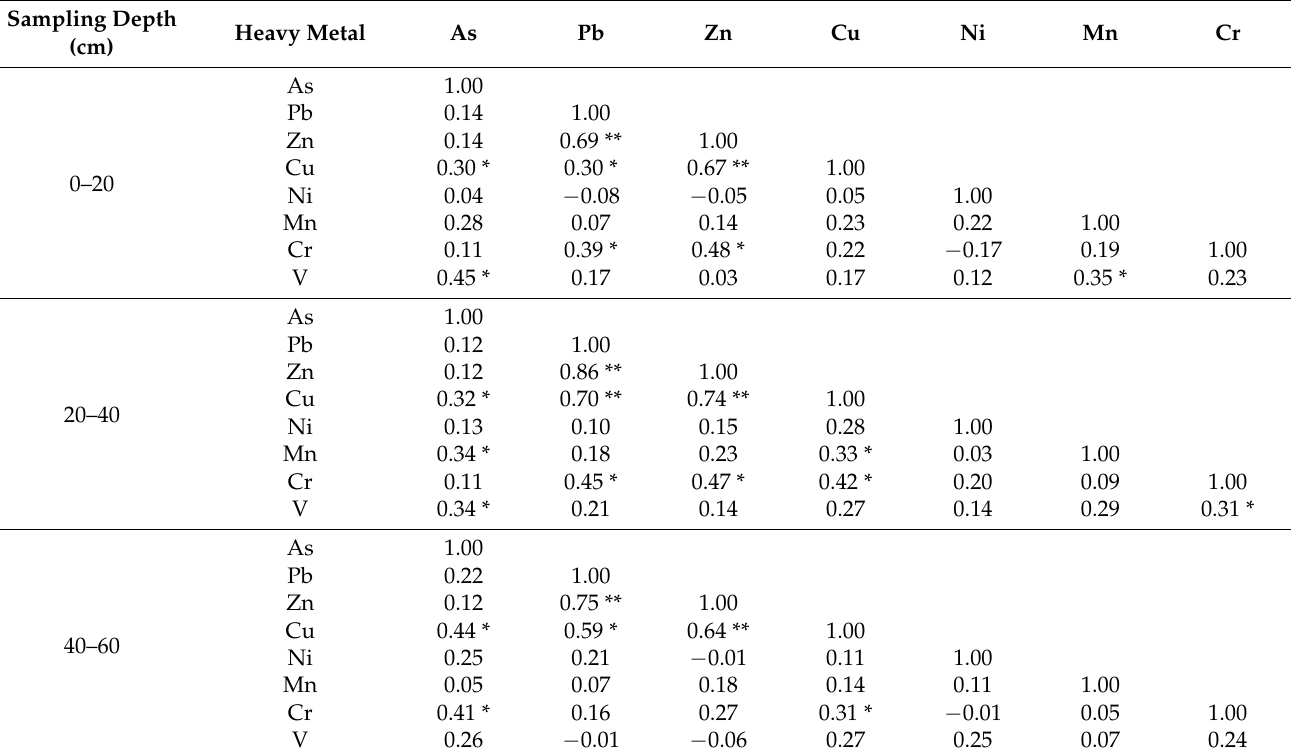
Table 2. Pearson correlation coefficient of soil heavy metal contents at different sampling depths along the Shuimo